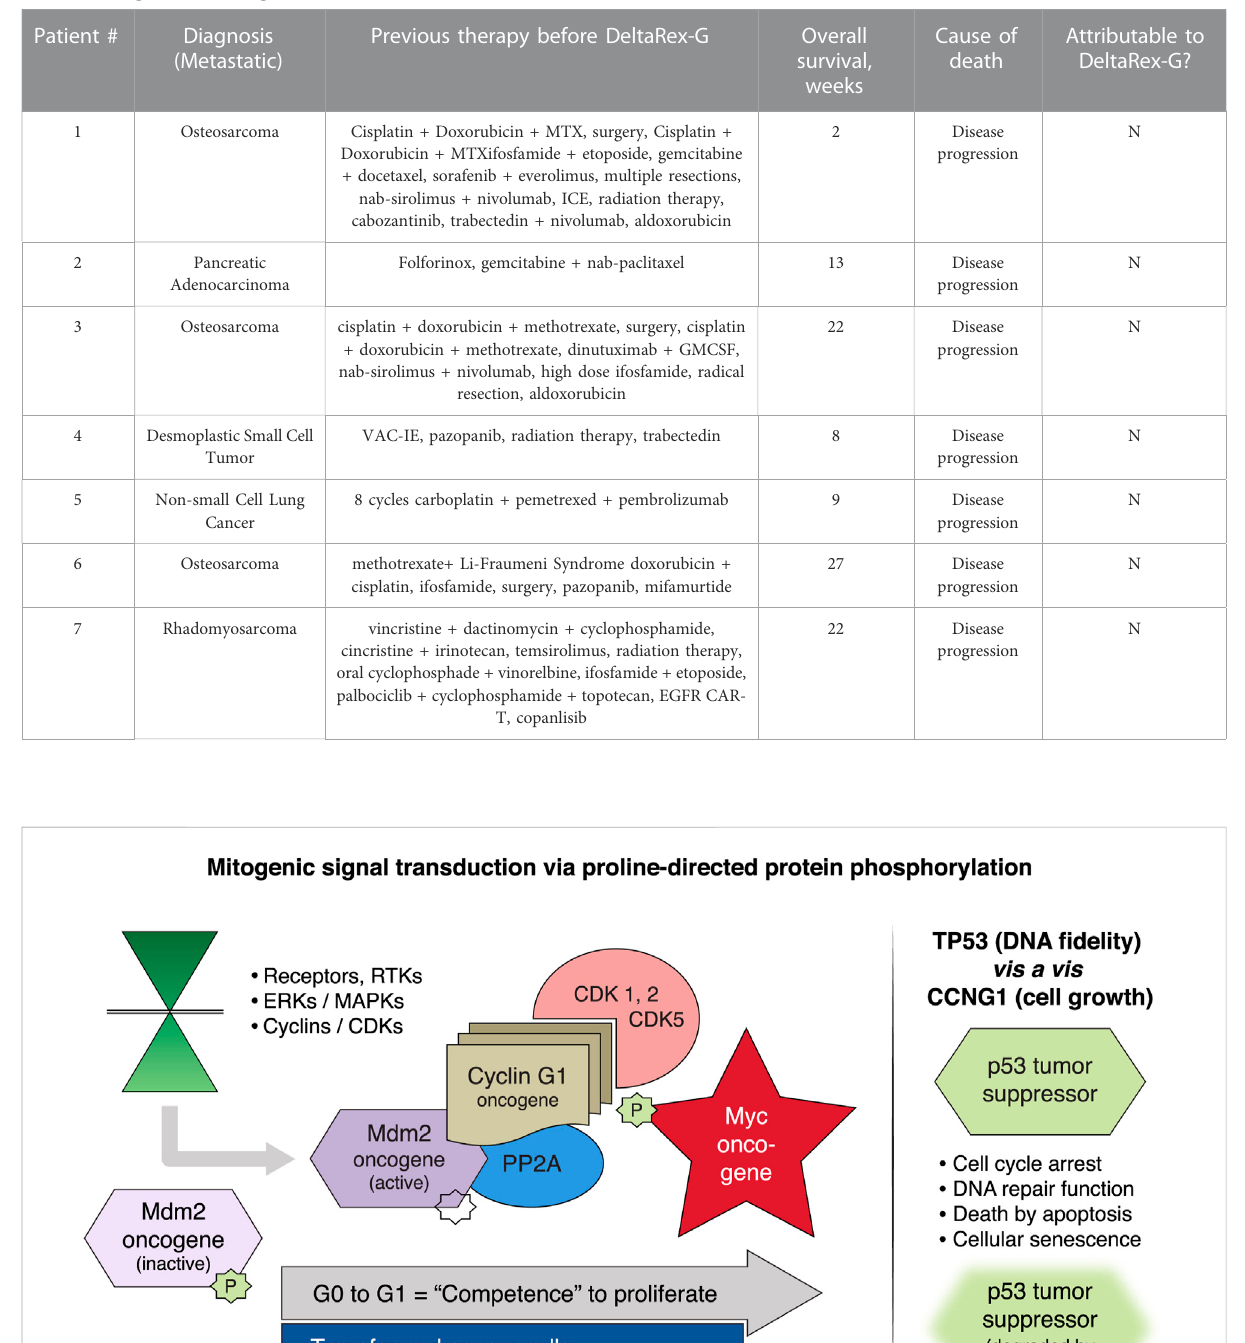
TABLE 5 Listing of deaths, diagnosis, overall survival, cause of death and attribution.